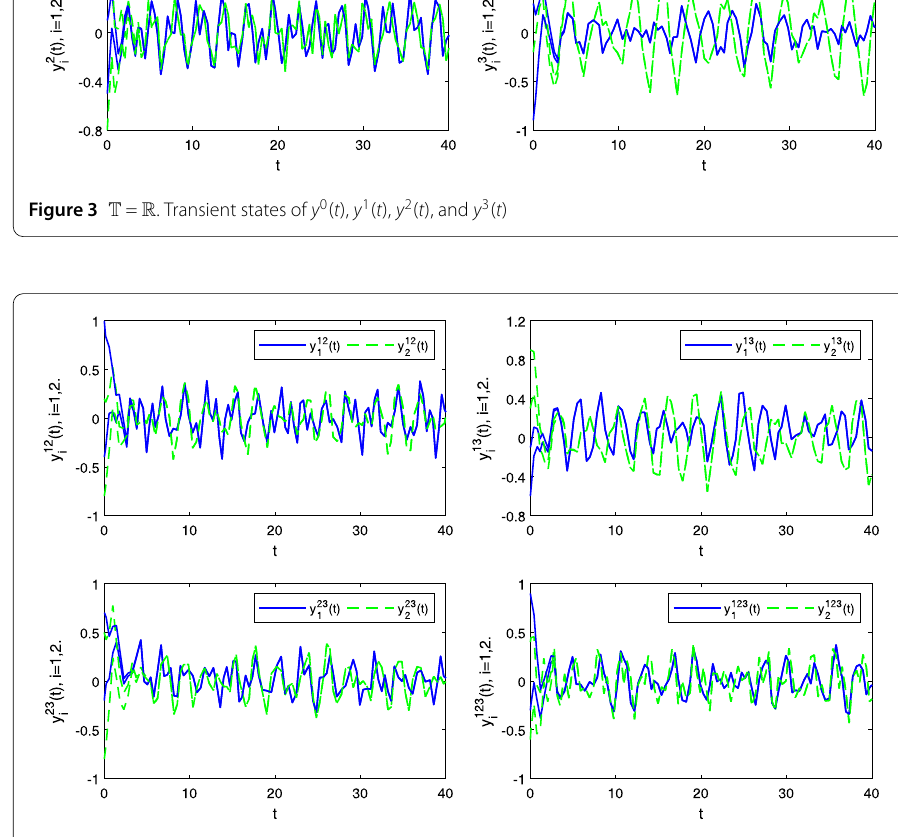
Figure 4 T = R . Transient states of y 12 ( t ), y 13 ( t ), y 23 ( t ), and y 123 ( t )